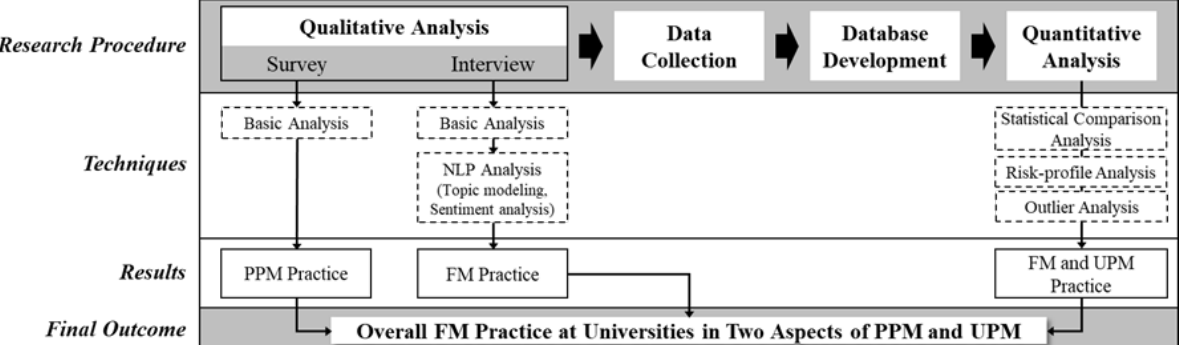
Figure 2. Overall research framework.